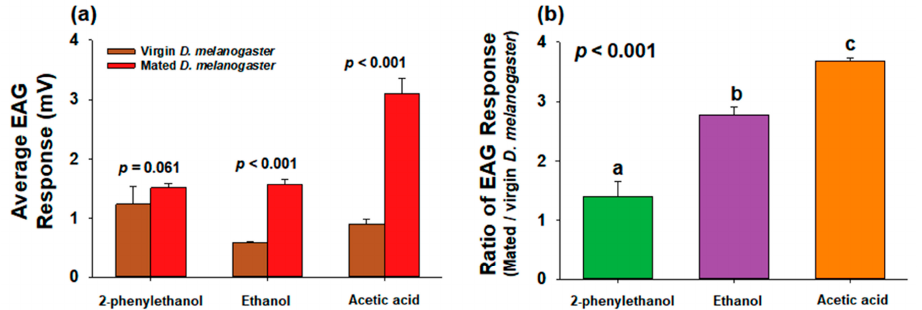
Figure 6. Comparison of ( a ) integrated EAG response values between virgin and mated female D. melanogaster and ( b ) ratio of EAG response values between two flies (mated/virgin). Student’s t -test was used to compare the ( a ) average EAG values between the two females ( p < 0.05) and the ( b ) ratios of EAG response values were statistically analyzed using one-way ANOVA. Data are presented as the mean ± standard error. EAG, electroantennogram.